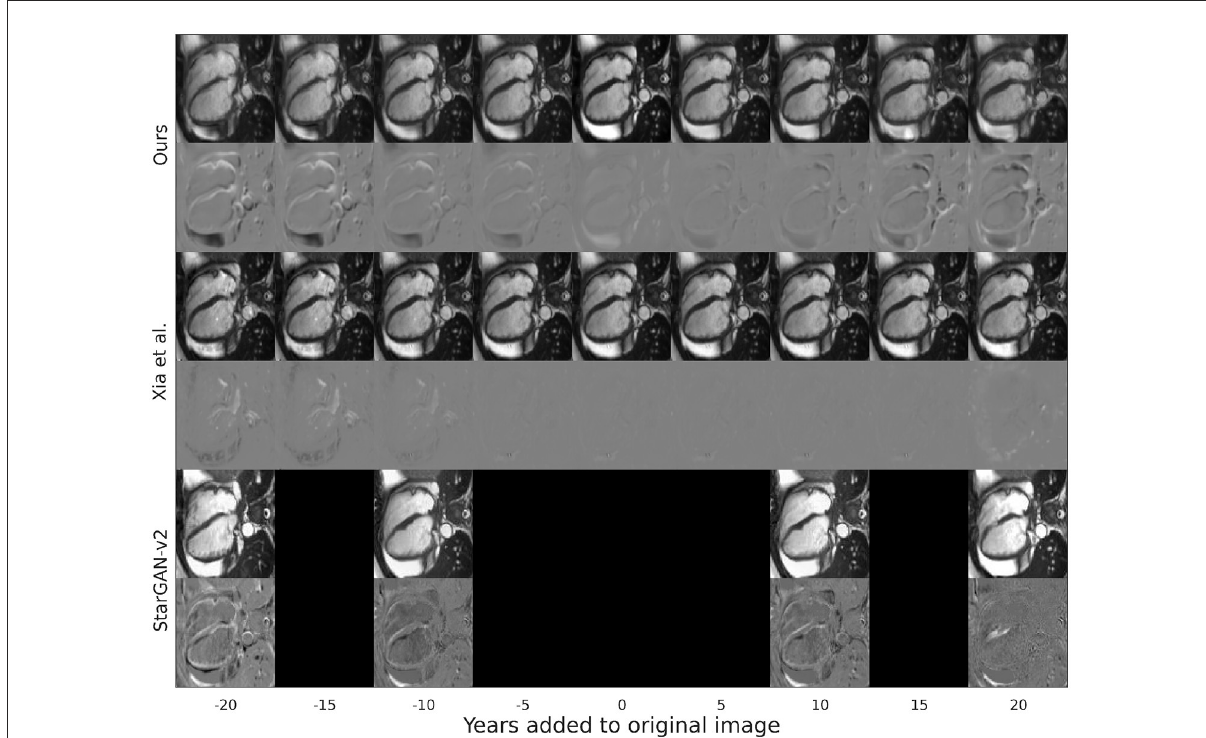
FIGURE3 Synthetic aged and rejuvenated images for a randomly selected subject from the test set for the current proposal and the two baselines. Each pair of rows contain the generated image and the mapping applied to the original image to obtain it. The column with age gap equal to zero represents the reconstructed image. Reproduced by kind permission of UK Biobank © .